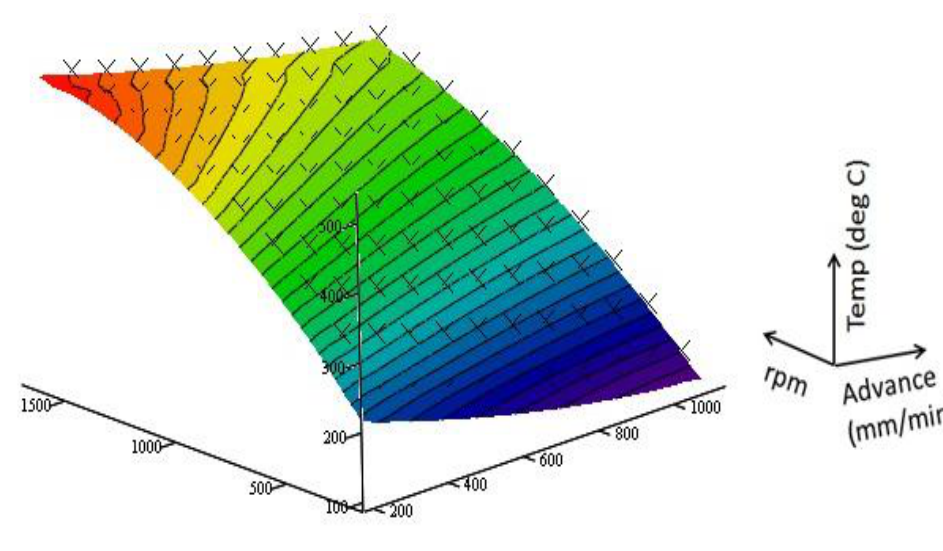
Figure 7. Least square fit graphed with MCS data